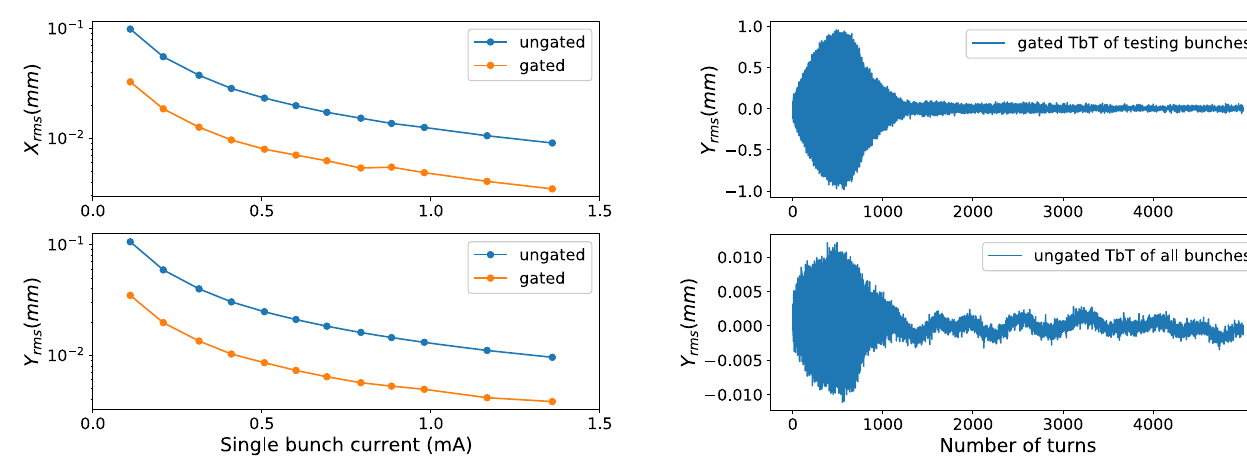
FIG. 6. Comparison of the BPM resolutions for gated and ungated data. Gated BPM data resolution is measured ∼ 3 times better than the ungated data in both the horizontal and vertical planes.